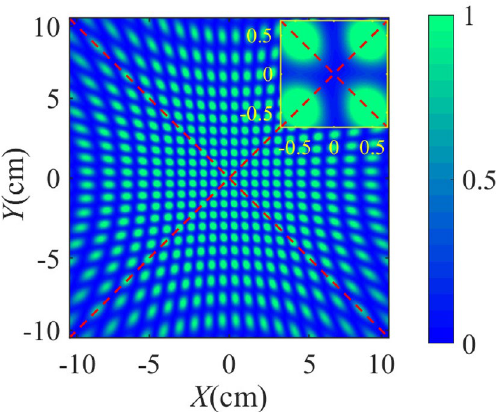
15 . It also means order r =